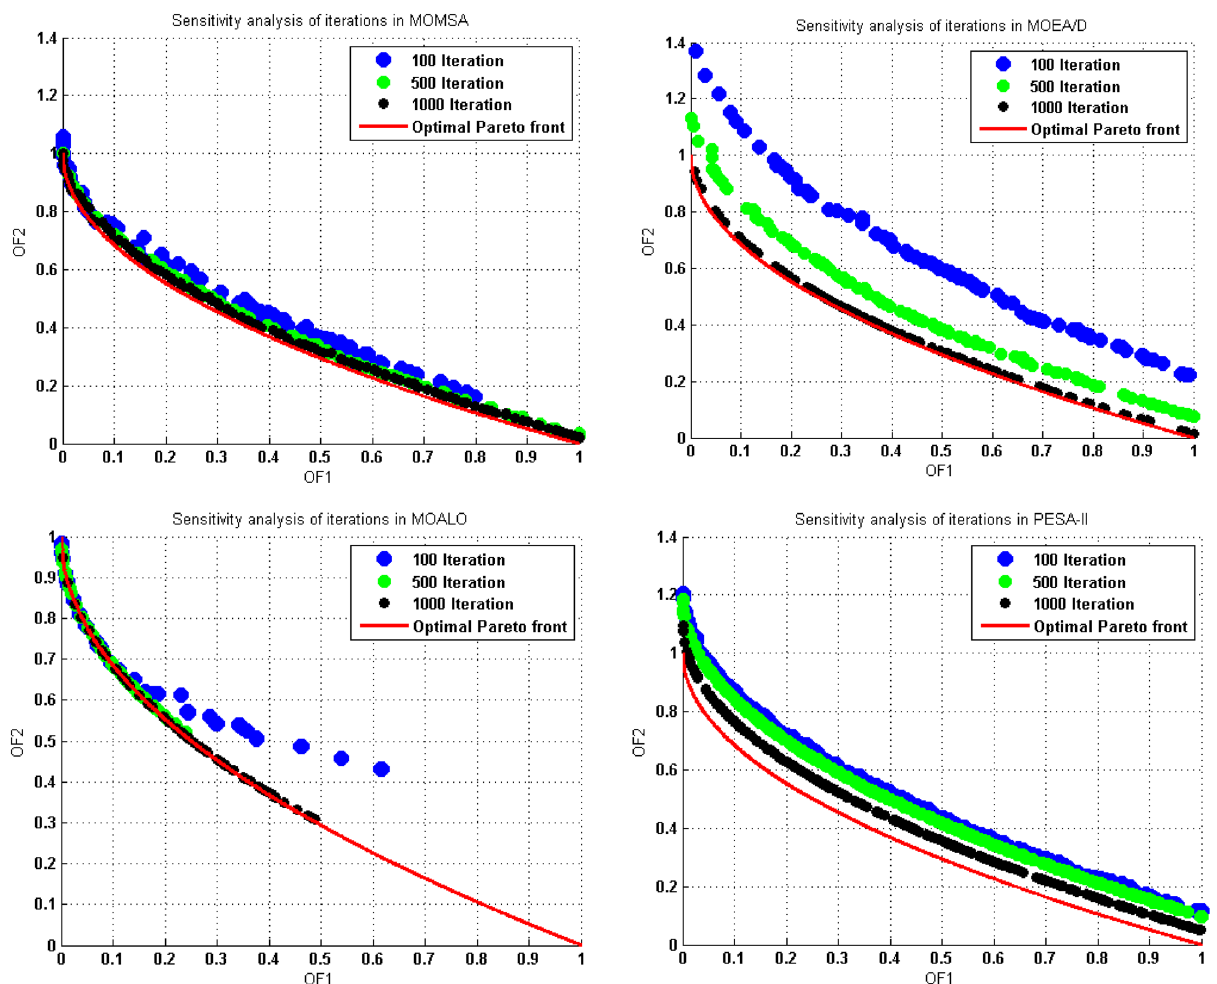
Figure 6. Sensitivity analysis on the number of iterations in the ZDT1 multi-objective test function.